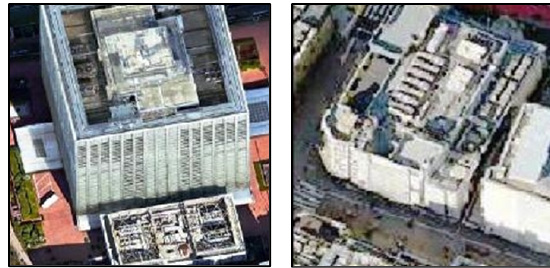
Figure 9 . Example of building images estimated as detached buildings